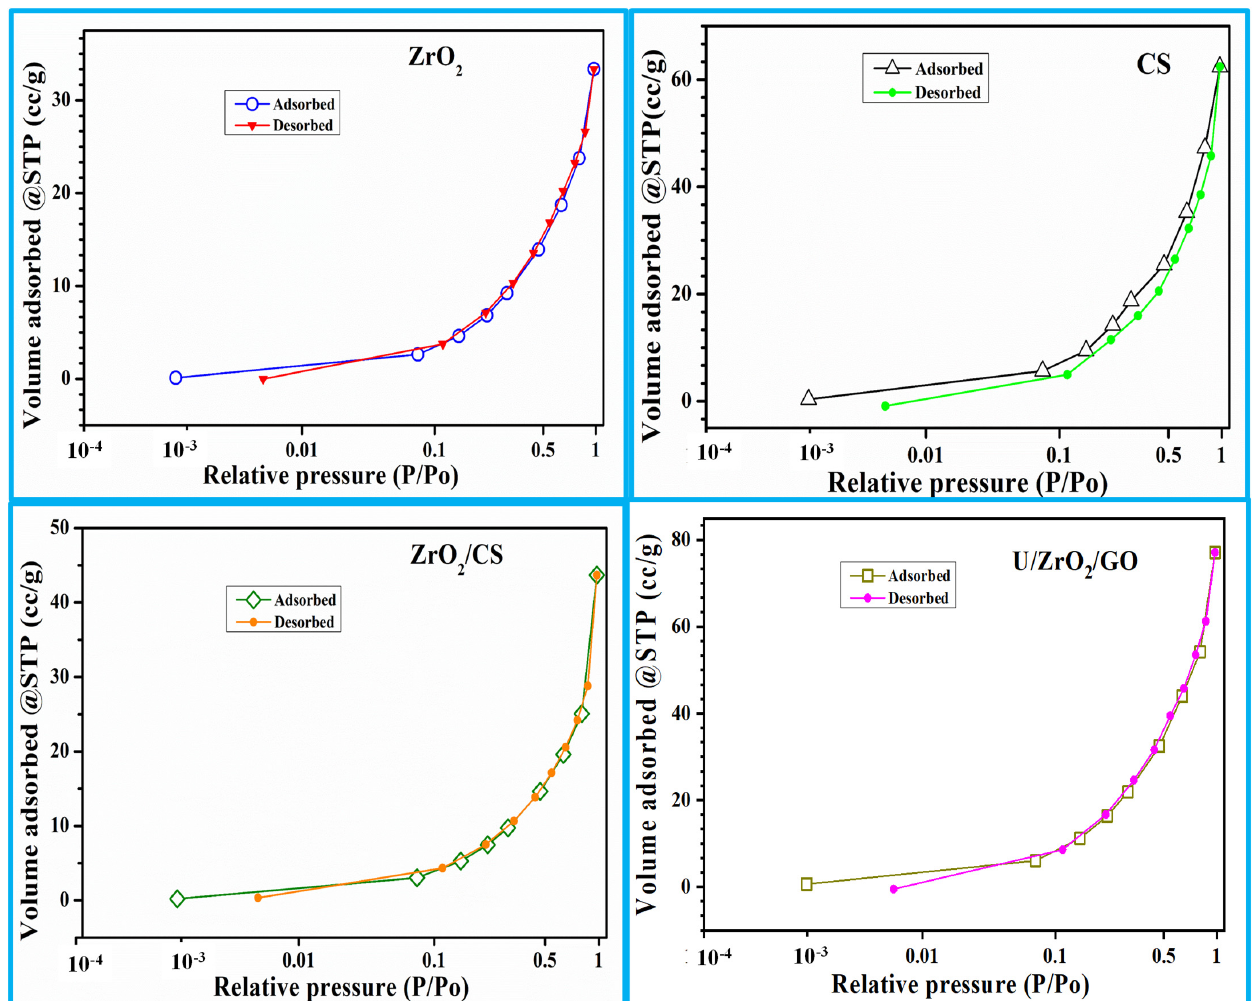
Figure 3. ZrO 2 , CS, ZrO 2 /CS, and U/ZrO 2 /CS N 2 adsorption/desorption isotherm. ZrO 2 had a BET surface area of 27.65 m 2 /g, according to Table 1. The isotherms of CS were altered once ZrO 2 was added. Because the specific surface area, pore volume, and pore size differences between ZrO 2 and CS were so large, it is reasonable to believe that ZrO 2 coated CS pores. ZrO 2 improved the CS’s ability to adsorb uranium ions by increasing its pore size and surface area. A decrease in the surface area, pore size, and pore volume of the adsorbents evaluated after adsorption was seen as a result of uranium ion